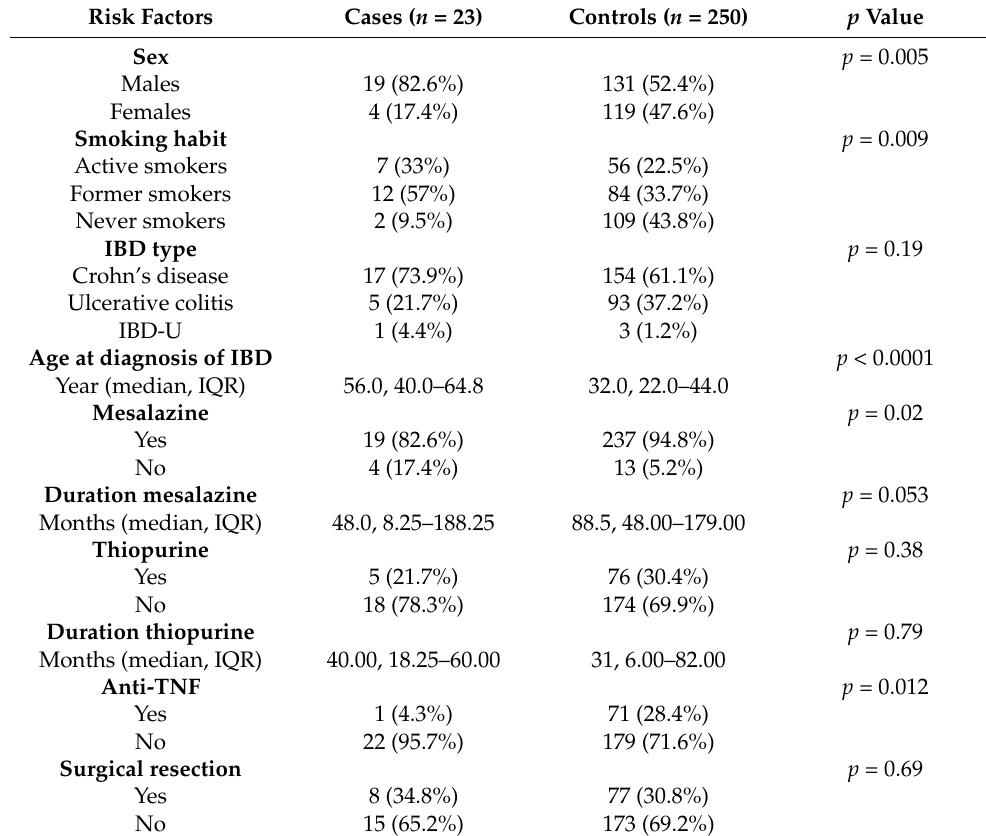
Table 1. Comparison of cases and controls.